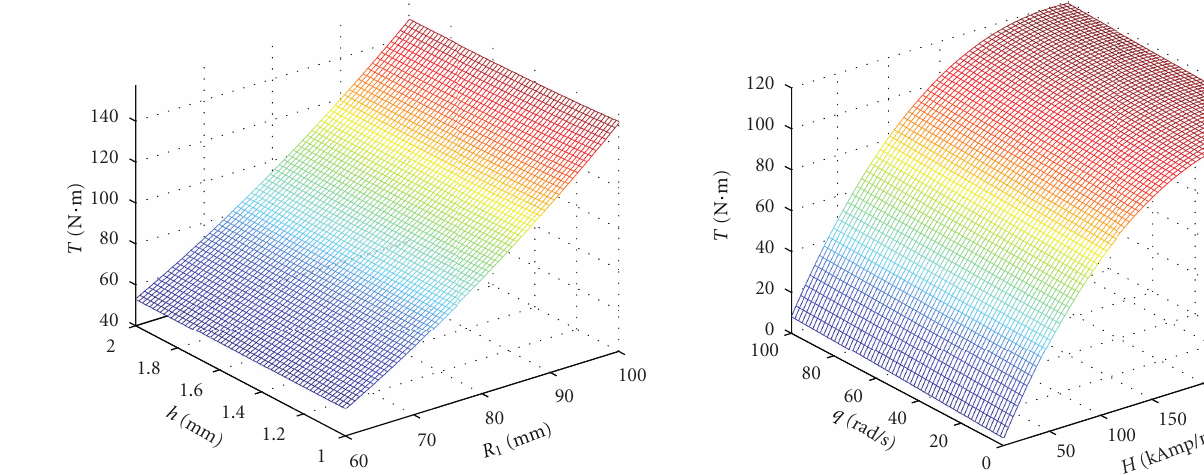
Figure 9: Torque versus magnetic field strength H and rotative speed di ff erence q